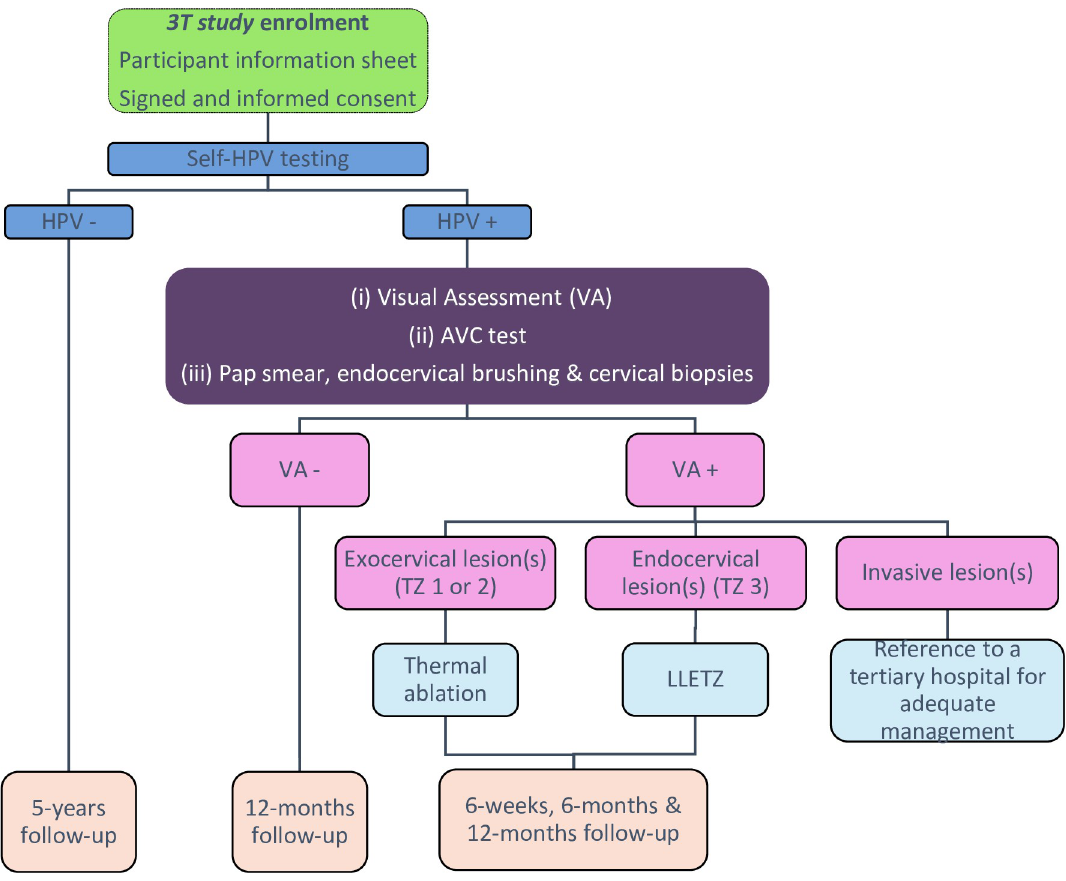
Fig 2. Flowchart of the clinical trial. Abbreviations: TZ = Transformation zone, LLETZ = Large loop excision of the transformation zone.